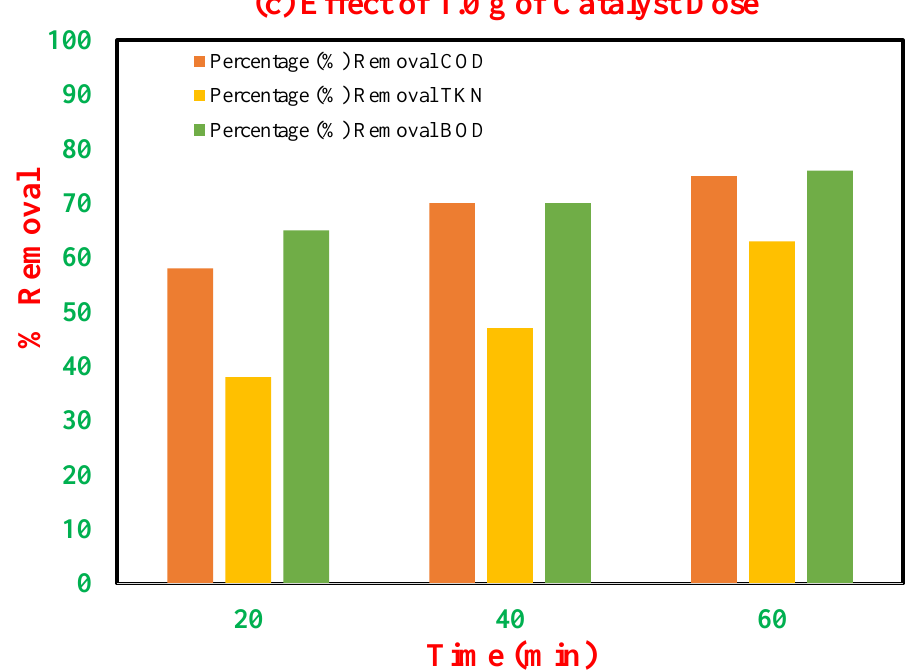
Figure 7. Simultaneous dose and contact time optimization for catalytic ozonation ( a ) 0.25 g, ( b ) 0.5 g, and ( c ) 1.0 g of catalyst dose, respectively.